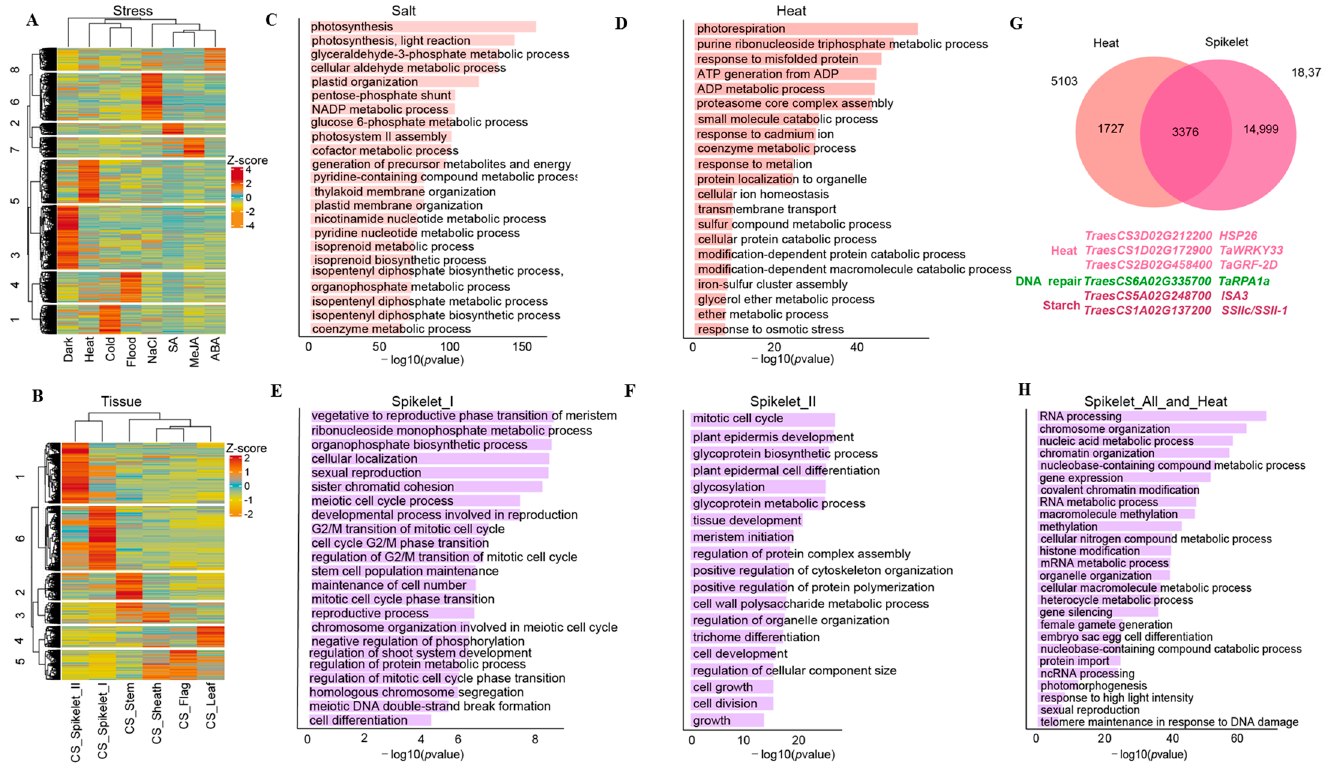
Figure 3. Expression patterns of core genes in abiotic stresses and multiple tissues. ( A ), The expression level clustering result of core genes in the stress treatment. ( B ), The expression level clustering result of core genes in different tissues, all clustering results were transformed by Z-score, and the genes with the sum of FPKM less than three were excluded for further analyses. ( C - F ), GO enrichment analyses of different genes. GO enrichment analyses of heat stress ( C ), salt stress ( D ) and core genes with high expression levels in spikelet_I ( E ) and spikelet_II ( F ). ( G ), Venn diagram of genes highly expressed in heat stress and genes highly expressed during the spikelet development, genes listed below the Venn diagram indicating reported genes related to heat response, starch synthesis and DNA repair. ( H ), GO enrichment analyses of highly expressed genes in heat stress and spikelet development.